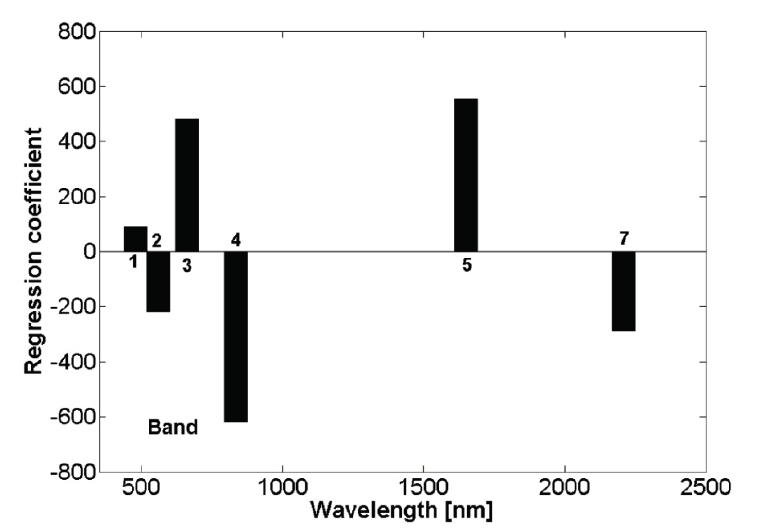
Figure 4. PLS regression coefficients of the six bands of Landsat